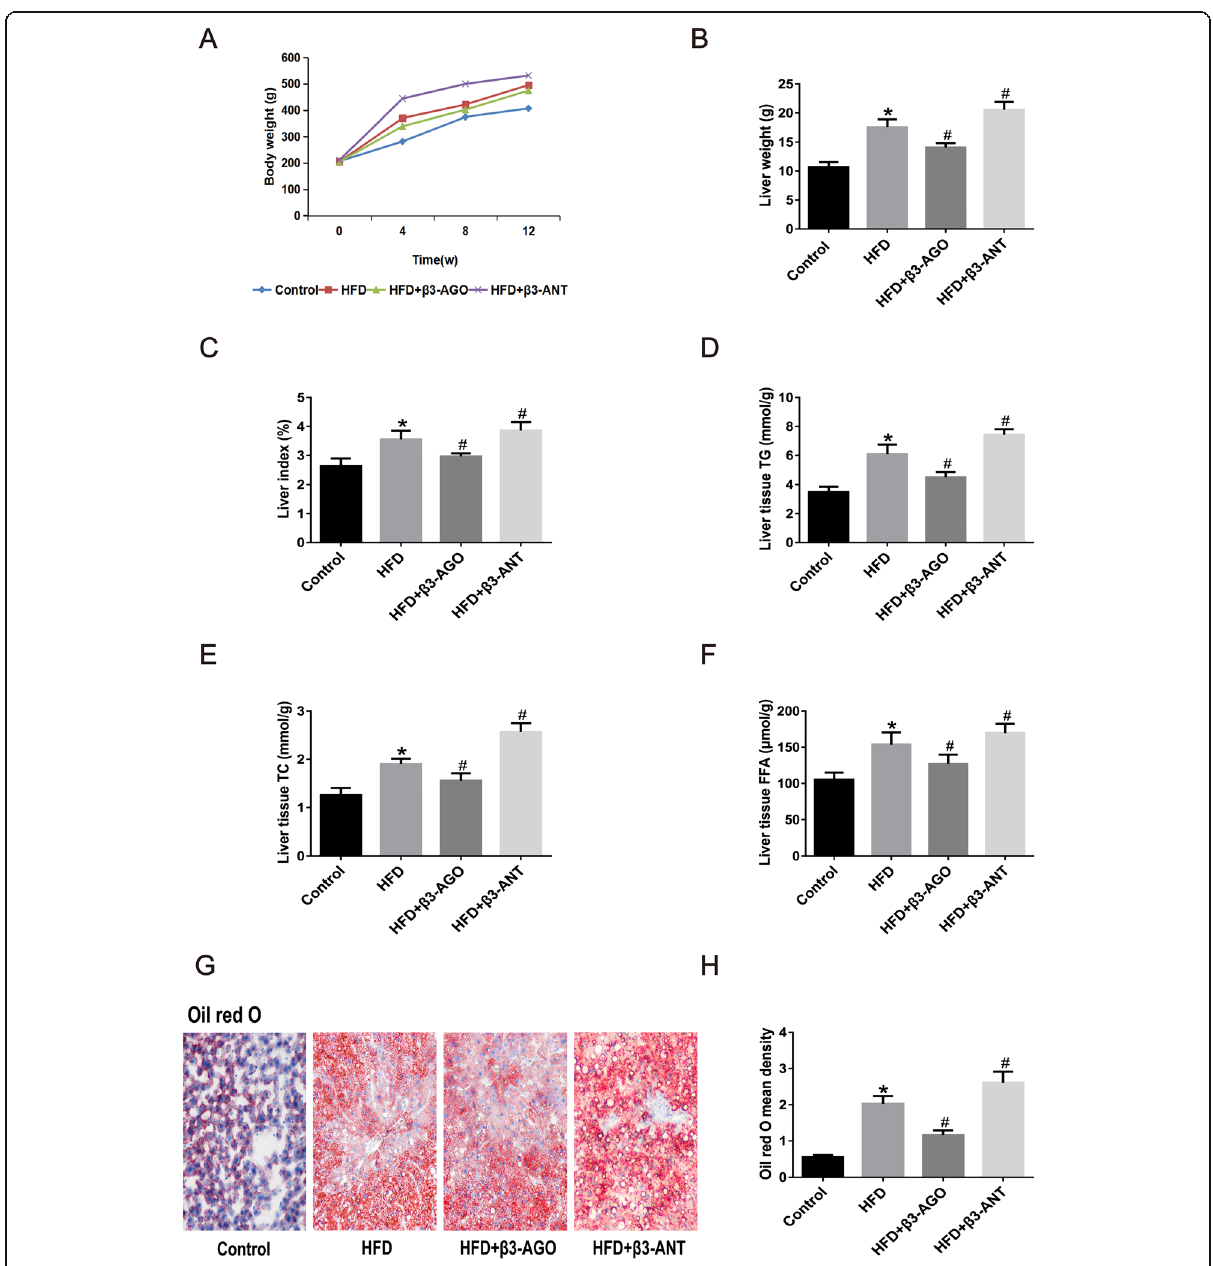
Fig. 3 The β 3-AR agonist BRL37344 ameliorated HFD-fed rat liver steatosis, exerting a protective effect. a Rat body weight at 0, 4, 8, and 12 weeks. b Liver weight at the 12th week in the control, HFD, HFD + β 3-AGO and HFD + β 3-ANT groups. c Liver index values at the 12th week in the control, HFD, HFD + β 3-AGO and HFD + β 3-ANT groups. d Liver homogenate TG levels (mmol/g). e Liver homogenate TC levels (mmol/g). f Liver homogenate FFA levels ( μ mol/g). g Oil red O was used to visualize lipid droplets in the hepatocytes. The magnification is 200×. Lipid droplets are stained light red, and nuclei are stained blue. h Quantitative analysis of lipid droplets in hepatocytes. TG: triglyceride. TC: total cholesterol. FFA: free fatty acid. * P < 0.05 vs the control group, # P < 0.05 vs the HFD group; n = 8 per